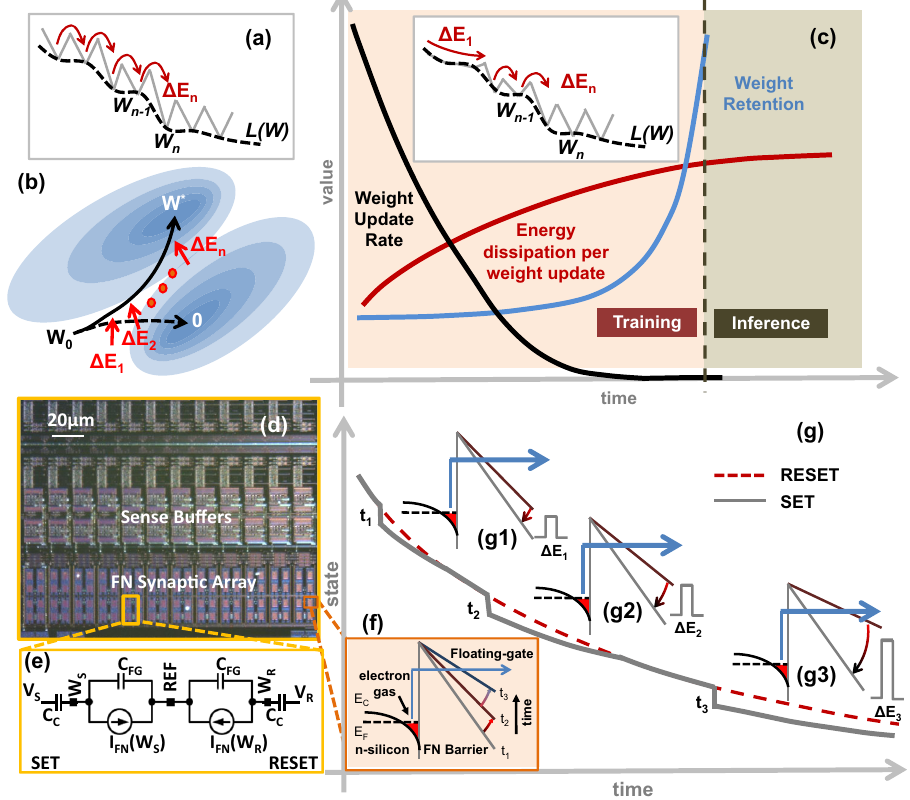
Fig. 1 Motivation and principle of operation for the proposed synaptic memory device. a Conventional non-volatile analog memory where transition between analog static states ( W n − 1 , W n ) dissipates energy ( Δ E n ); b dynamic analog memory where an external energy ( Δ E 1 , Δ E 2 … Δ E n ) is used to modulate the trajectory of the memory states ( W 0 ) towards the optimal solution ( W “ ); c desired analog synapse characteristic where the memory retention rate is traded-off with the write energy; reducing the energy dissipation per weight update in training phase by matching the dynamics of the dynamic analog memory to the weight decay as shown in (inset) where the height of the energy barrier ( Δ E n ) increases as the training progresses ( d ) micrograph of a fabricated DAM array along with ( e ) its equivalent circuit where the leakage current I FN is implemented by ( f ) the electron transport across a Fowler – Nordheim (FN) tunneling barrier; g implementation of the FN tunneling based DAM where dynamic states g1 – g3 determines the